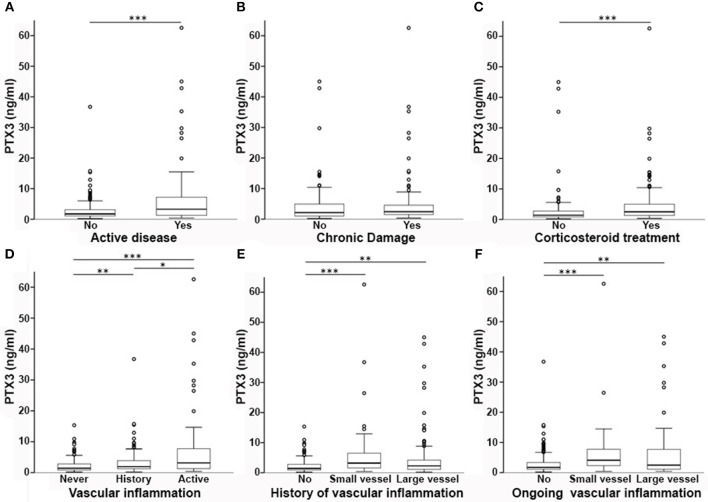
PTX3 levels and disease phenotypes. In this multi-panel graph, differences in PTX3 plasma levels among phenotype groups are highlighted. PTX3 levels were higher in patients with active disease (A), but not with accrued irreversible damage (B). PTX3 was also higher in patients on corticosteroids (C). (D) Depicts the existing differences between patients with vs. without a history of vasculitis and between active or quiescent vasculitis at time of sampling. In (E,F) patients are stratified according to a history (E) or ongoing activity (F) of small- or large-vessel vasculitis associated with higher levels of PTX3 when compared to no vasculitis. *p < 0.05; **p < 0.01; ***p < 0.001.